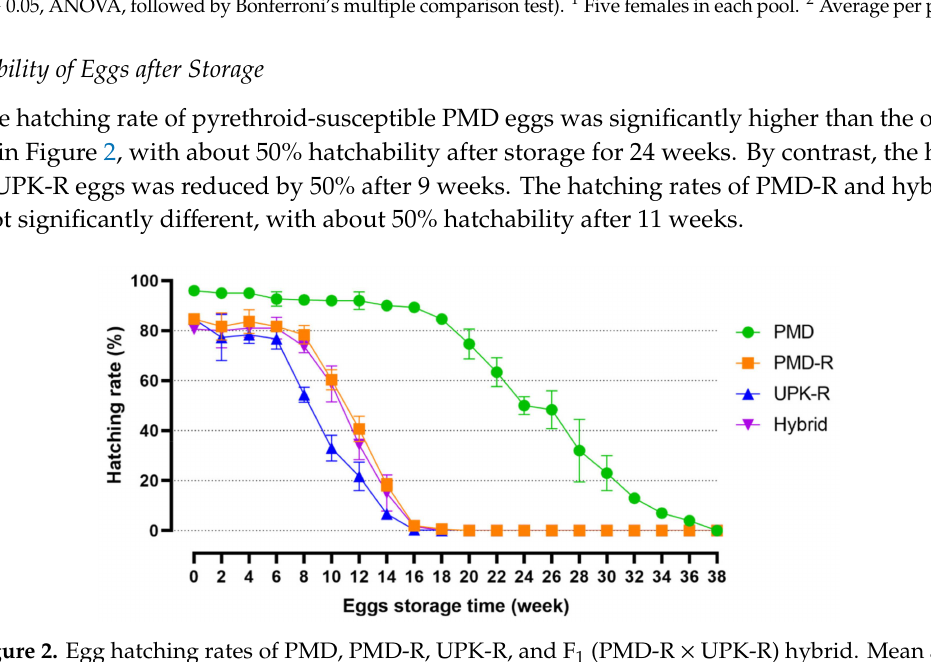
Figure 2. Egg hatching rates of PMD, PMD-R, UPK-R, and F 1 (PMD-R × UPK-R) hybrid. Mean and standard deviation are